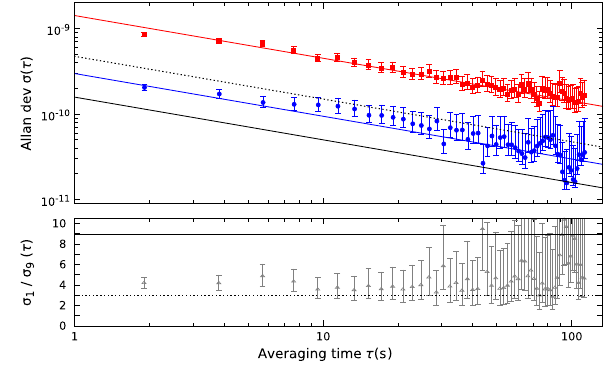
FIG. 7. Atomic clock implementing a PLL. Top: Allan- frequency standard deviation σ 1 for a normal Ramsey clock with interrogation time T ¼ 1 ms (red line) and σ 9 for a clock implementing the phase lock between the LO and the atomic superposition state for nine successive, correlated interrogations on the same atomic ensemble, for a total interrogation time of 9 × T ¼ 9 ms (blue line). The dead time is in both cases ¼ 1 . 9 s. The red and blue lines are fits to the data, with a T D slope set to τ − 1 = 2 . The continuous black line lies a factor 9 below the red curve and represents the best achievable level of the phase-lock sequence for the same number of interrogations. The dashed black line lies a factor 3 below the red curve and is the optimum level for nine consecutive uncorrelated Ramsey measurements with duration T each and the same total cycle time. Bottom: The gray triangles represent the ratio of the Allan deviation for the two clocks; the solid and dashed lines corre- spond to the factors 9 and 3 from the top